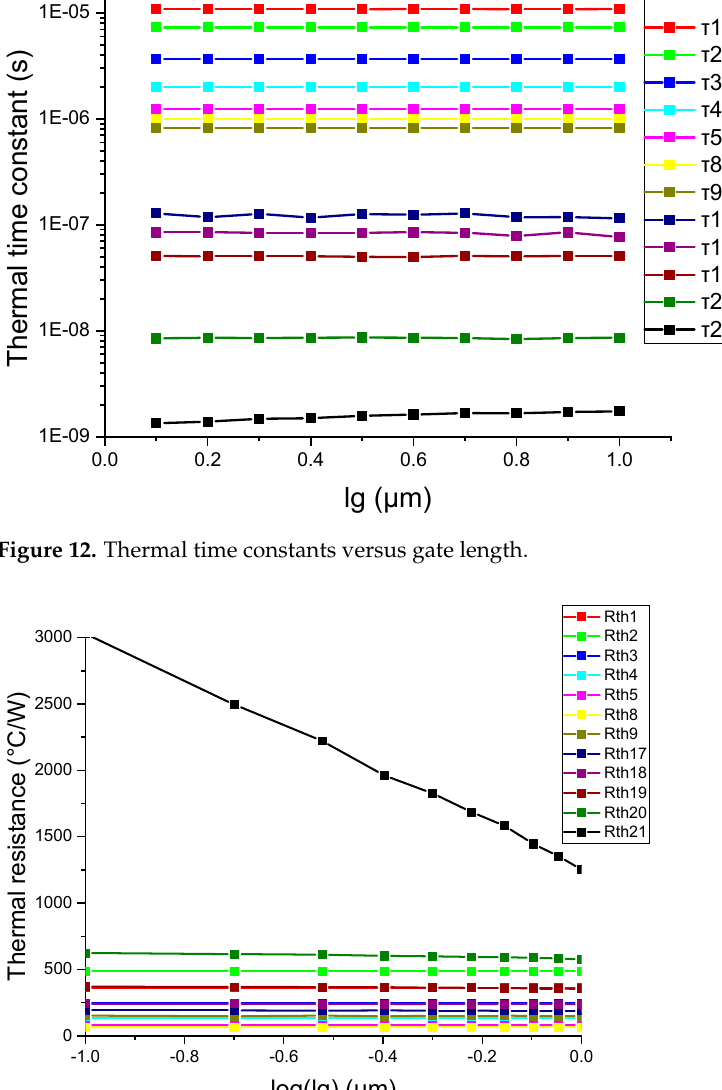
Figure 13. Thermal resistance versus gate length . Foster-type circuit with 20 constant-value RC blocks with one variable-parameter RC